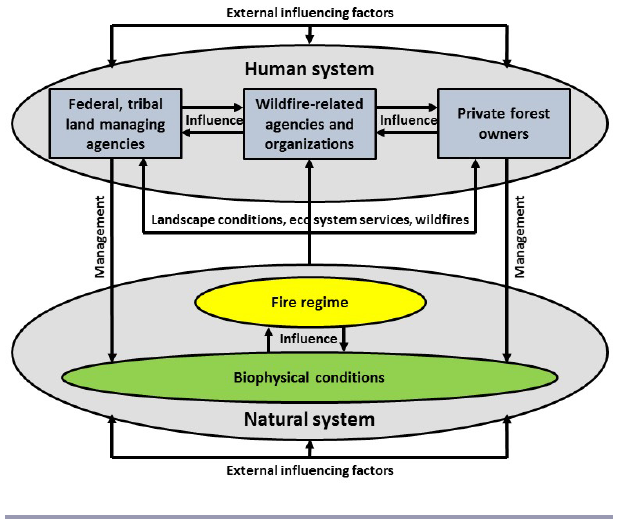
Fig. 1 . Conceptual coupled human and natural system model of a fire-prone